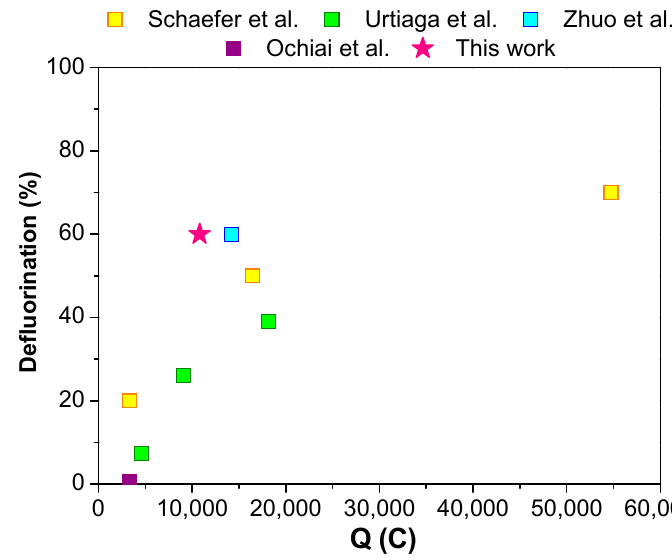
Figure 7. Process comparison in terms of defluorination against electric charge for PFOA electrooxidation with BDD anodes. Cathodes: Schaefer et al.—W [21], Urtiaga et al.—W [22], Zhuo et al.—BDD [23], Ochiai et al.—Pt [24], this work—Pt.